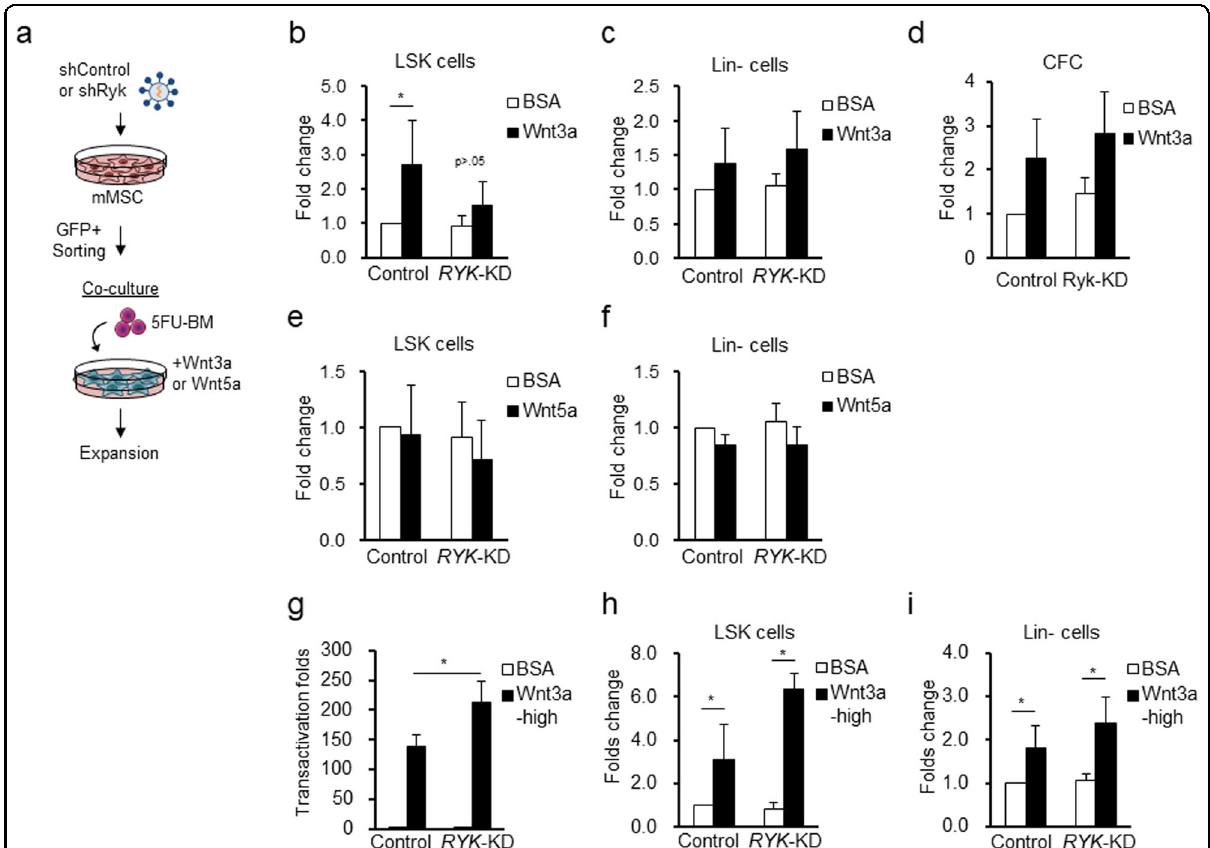
Fig. 4 KD of Ryk selectively impairs canonical Wnt-mediated niche activation for primitive subsets of hematopoietic progenitors. a Experimental design. MSCs with Ryk -KD were cocultured with 5-FU-enriched hematopoietic progenitors for 5 days in the presence or absence of Wnt ligands (Wnt3a or Wnt5a) followed by measurement of expansion of each indicated subpopulation of hematopoietic cells. b – d Effects of Ryk -KD on canonical Wnt ligand (Wnt3a)-mediated activation of niche function. The relative fold expansion of LSK (Lin − Sca-1 + c-Kit + ), lineage negative (Lin-) cells and colony forming cells (CFCs) relative to the coculture with control MSCs in the absence of Wnt ligands (mean ± SEM, * p < 0.05, n = 5) is shown. e , f Effects of Ryk -KD on niche activity of MSCs in response to noncanonical Wnt5a. The fold expansions of each indicated subpopulation of hematopoietic cells relative to the control group with BSA (mean± SEM, n = 5) are shown. g Transactivation folds induced by high-dose Wnt3a (100ng/ml) treatment in the control or Ryk -KD mMSCs were determined by the TOP/FOP ratio relative to the BSA-treated control (mean ± SEM, * p < 0.05, n = 4). h , i Effects of Ryk -KD on the niche activity of MSCs in response to high-dose canonical Wnt ligand (Wnt3a, 100 ng/ml). The relative fold expansion of LSK ( h ) and Lin- cells ( i ) relative to the coculture group with control MSCs (mean ± SEM, * p < 0.05, n = 4) is